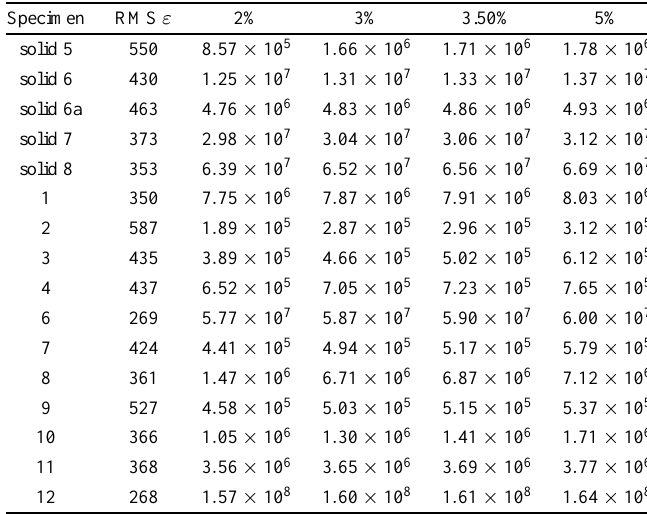
Cycle count using different values of D ! for failure criteria Specimen RMS " 2%